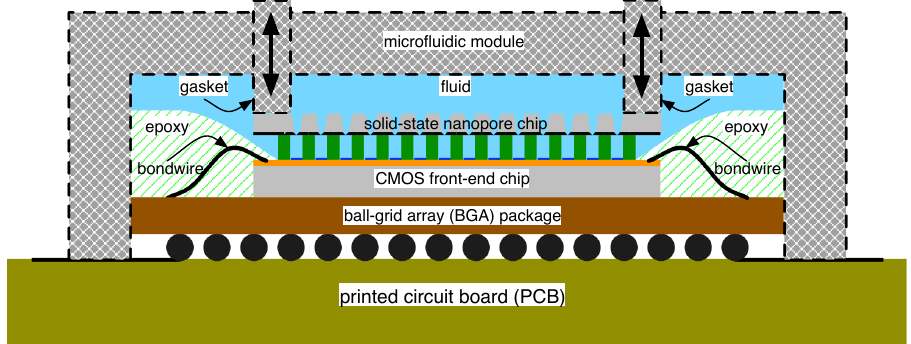
Figure 20. Cross-section of a solid-state nanopore array